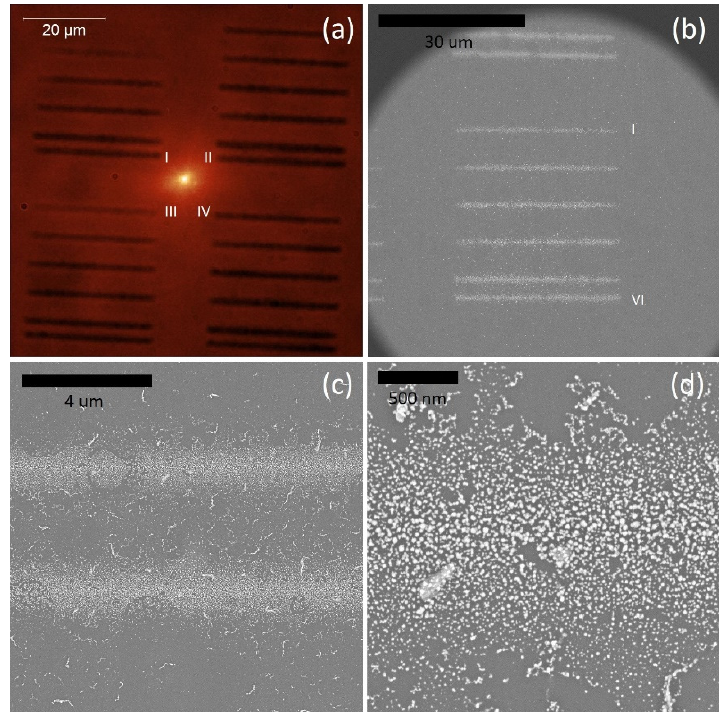
Figure 7. Photochemically synthesized silver islands observed with ( a ) a wide-field optical microscope in transmission mode, and ( b – d ) a scanning electron microscope.